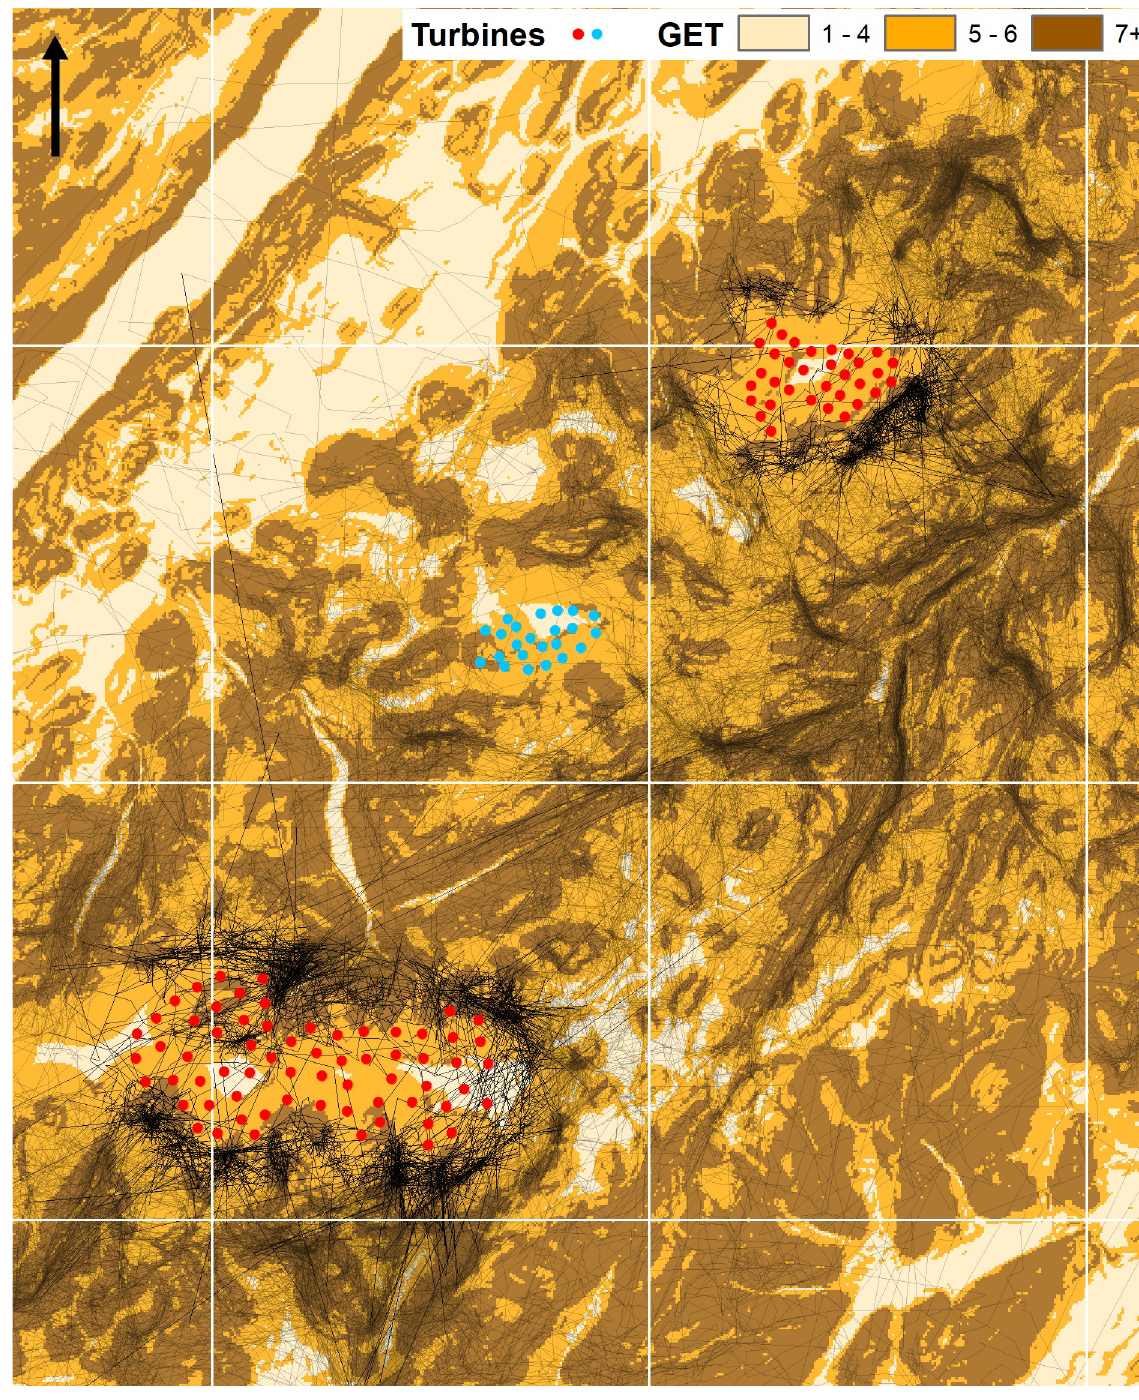
Fig 6. Flight lines derived from GPS/GSM-telemetry data after Stronelairg (lower array) had become fully operational in 2018 (see main text), with a darker emphasis on those within 1 km of the two study wind farms. Turbine locations are red (Stronelairg and Dunmaglass: study sites) or blue (Corriegarth) circles. The white overlay is 10 km grid square with backdrop of GET model predictions of habitat preference [45] in three classes of preference scores (see legend): arrow shows north. Note that in 3-D approximately 75% of flight lines passing ‘across’ the wind farms were at altitudes above the limits of the highest blade tip extension of turbines and < 1% were within a rotor blade width of the hub. Contains Ordnance Survey data © Crown copyright and database right 2017.